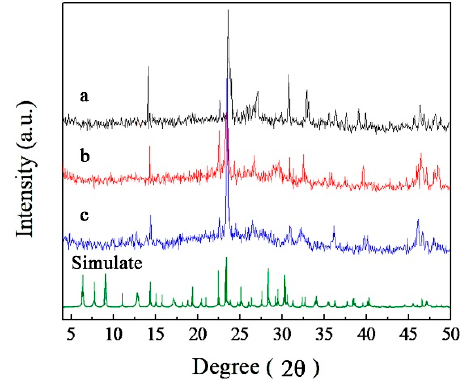
Figure 8. XRD patterns of fresh catalyst 1 ( a ), used one in cyclooctene epoxidation ( b ), used one in 1-octene epoxidation ( c ) and the simulated pattern.